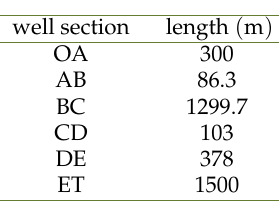
Table 9. Section length of modified six-section well